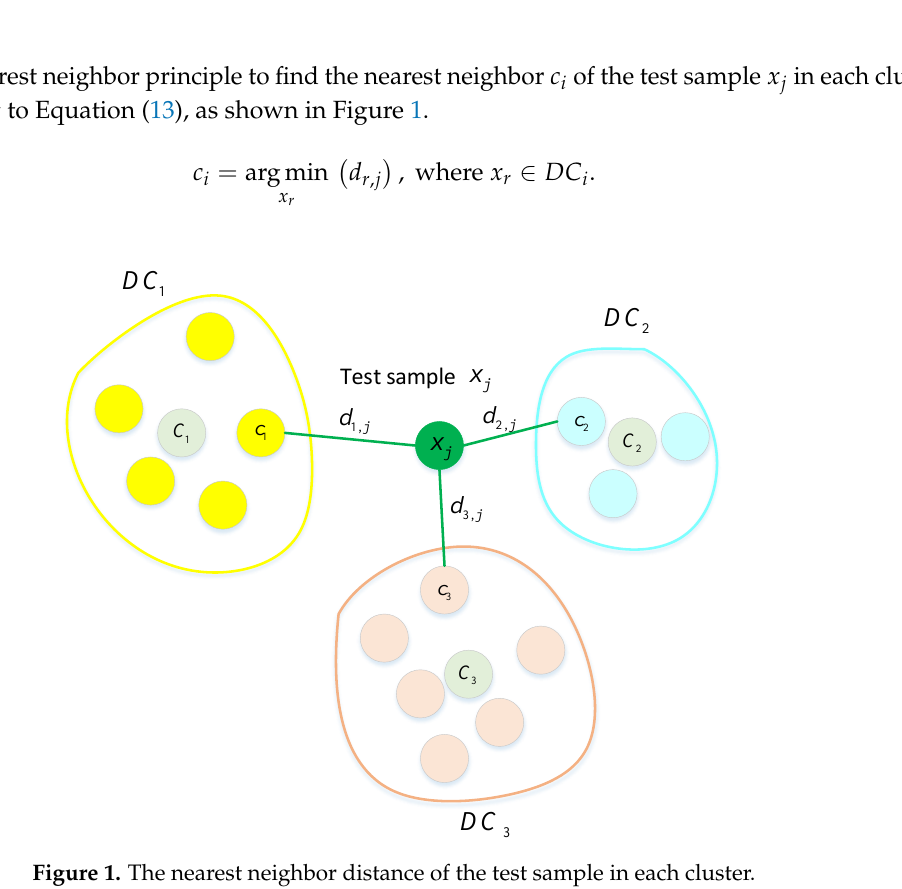
Figure 1. The nearest neighbor distance of the test sample in each